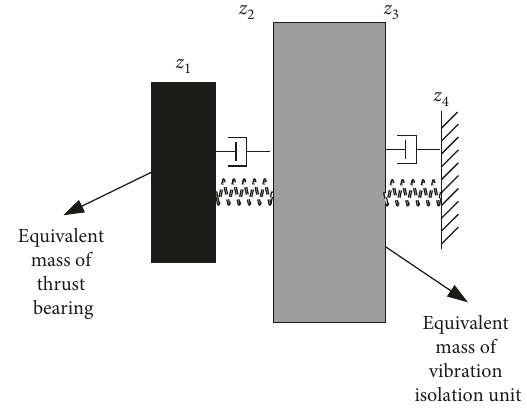
Figure 6: Local schematic diagram of the simplified model of thrust bearing, an